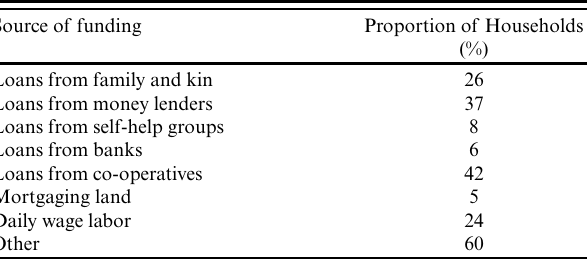
Table 6 . Sources of funding used by households to pay for costs of cultivation. (Each cell represented as proportion of all households [N =